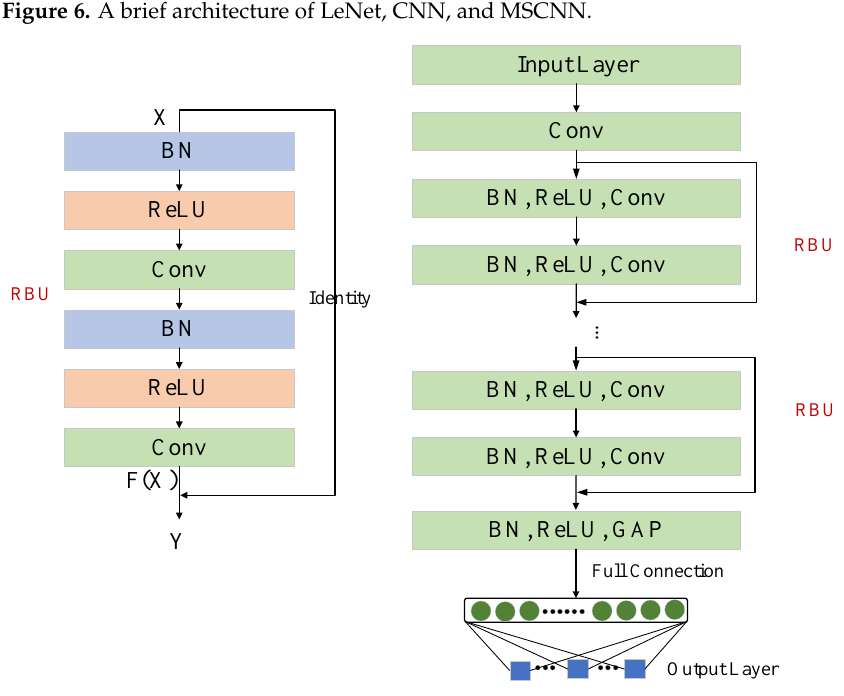
Figure 7. A brief architecture of